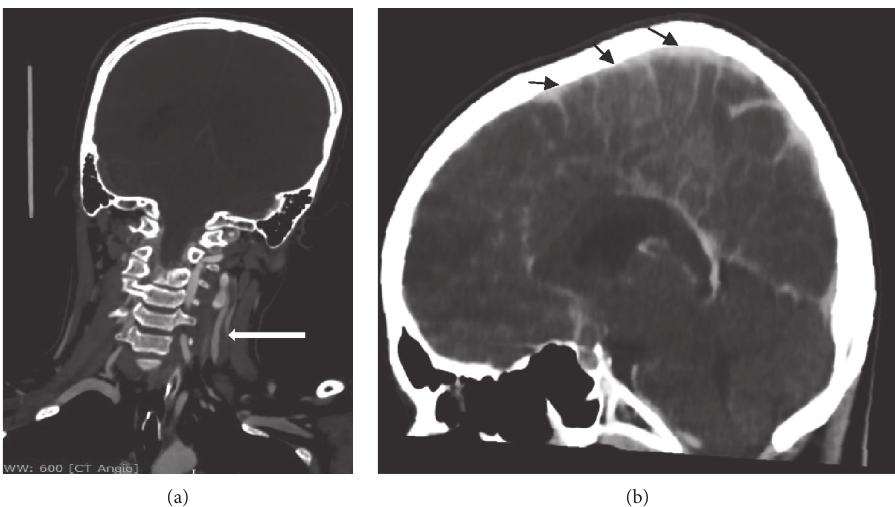
Figure 3: (a) Coronal CT scan of the neck demonstrating central thrombus in the left internal jugular vein (white arrow). (b) Sagittal postcontrast CT scan of the brain indicates no thrombosis in the superior sagittal sinus (black